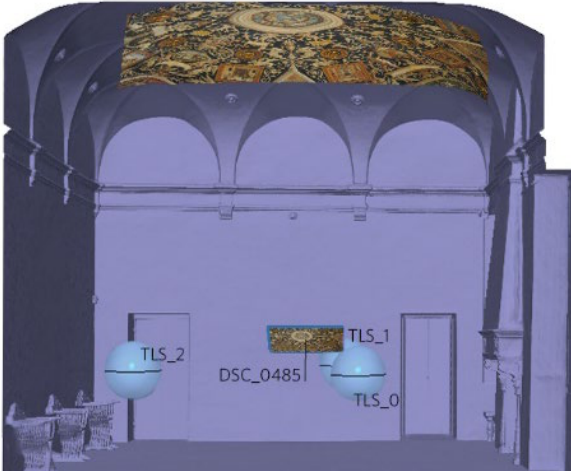
Figure 3 . Example of co-registration of a single frame image on the spherical images from TLS (Room 1).